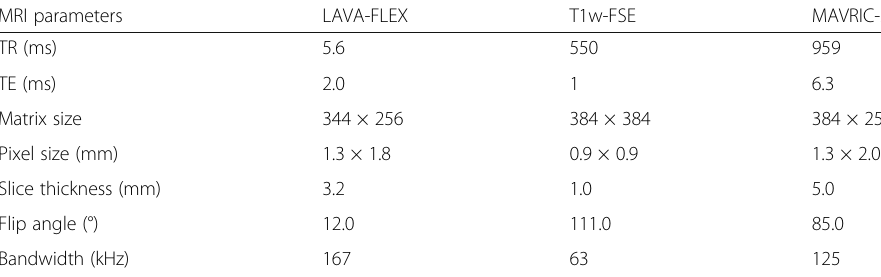
Table 1 Magnetic resonance imaging parameters MRI